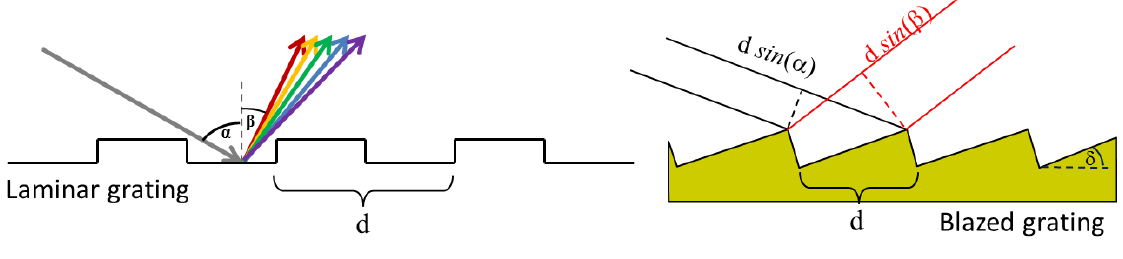
Figure 4. Profile of diffraction gratings: ( Left) Laminar (or lamellar) grating, α and β are the angle of incidence and diffraction respectively, d is the grating period; ( Right) Blaze (or blazed) grating, δ is the blaze angle. The light is diffracted in a direction where the difference in path between two rays arriving on the grating with a separation distance d, is equal to a multiple of the